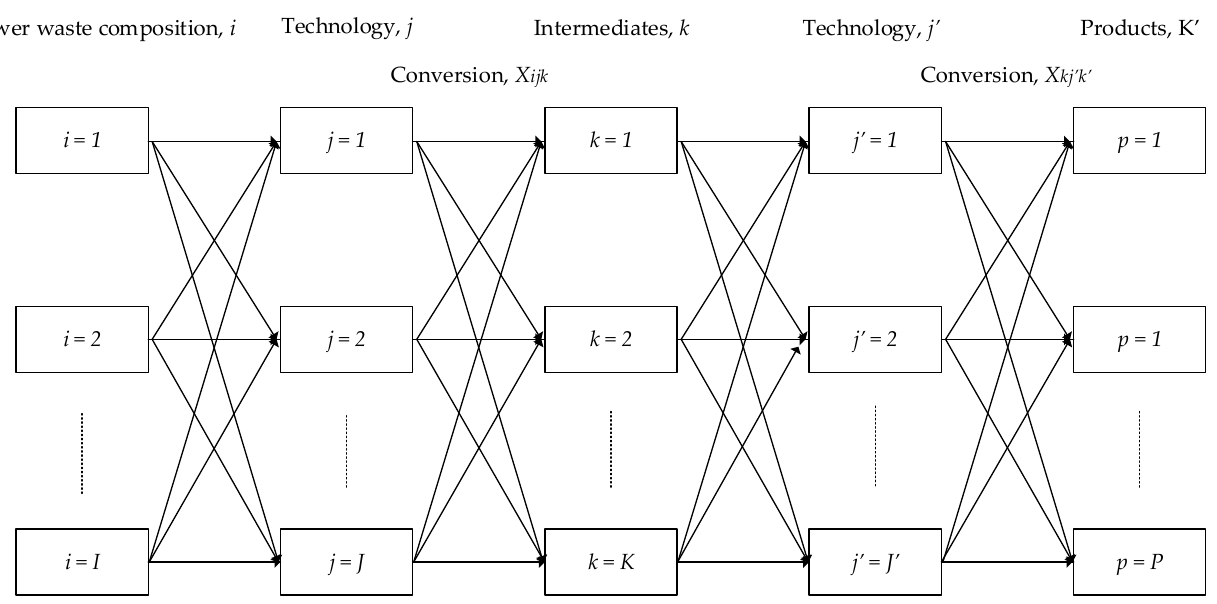
Figure 1. Generic superstructure for flower-waste biorefinery.